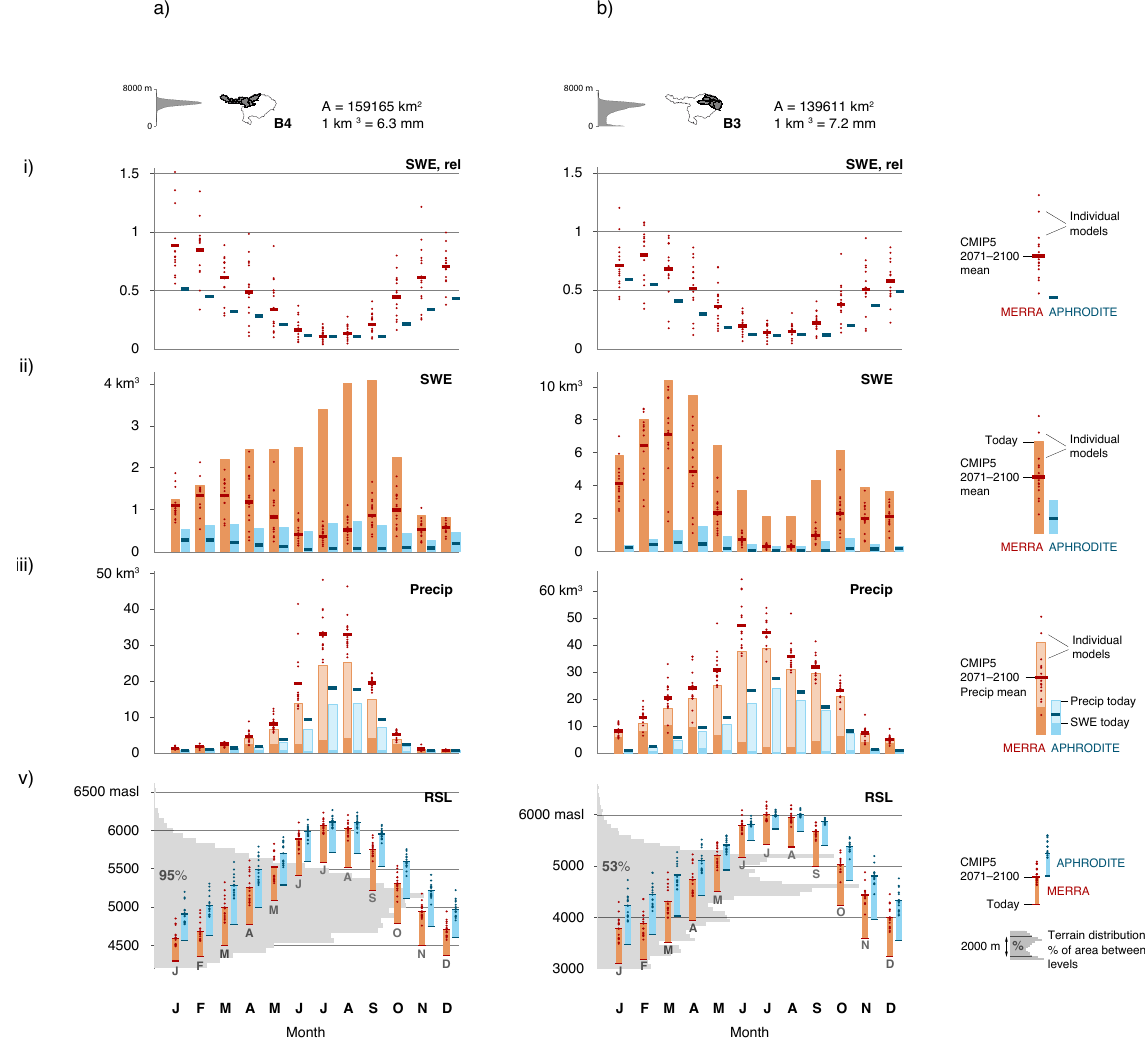
Figure 13. Monthly CMIP5 RCP8.5 change in snowfall, precipitation and rain/snow line elevation in the upper Brahmaputra clusters 4 (a) and 3 (b) . See Fig. 12 for a description of the